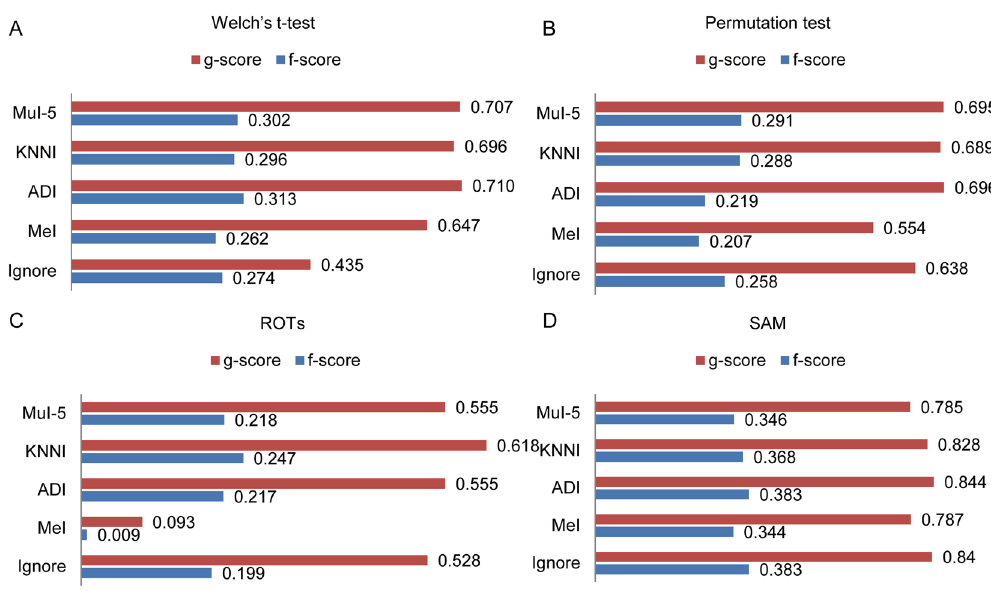
Figure 5. Bar charts of g-score and f-score for Welch’s t-test ( A ), permutation test ( B ), ROTs ( C ) and SAM ( D ) before and after four different imputation methods in